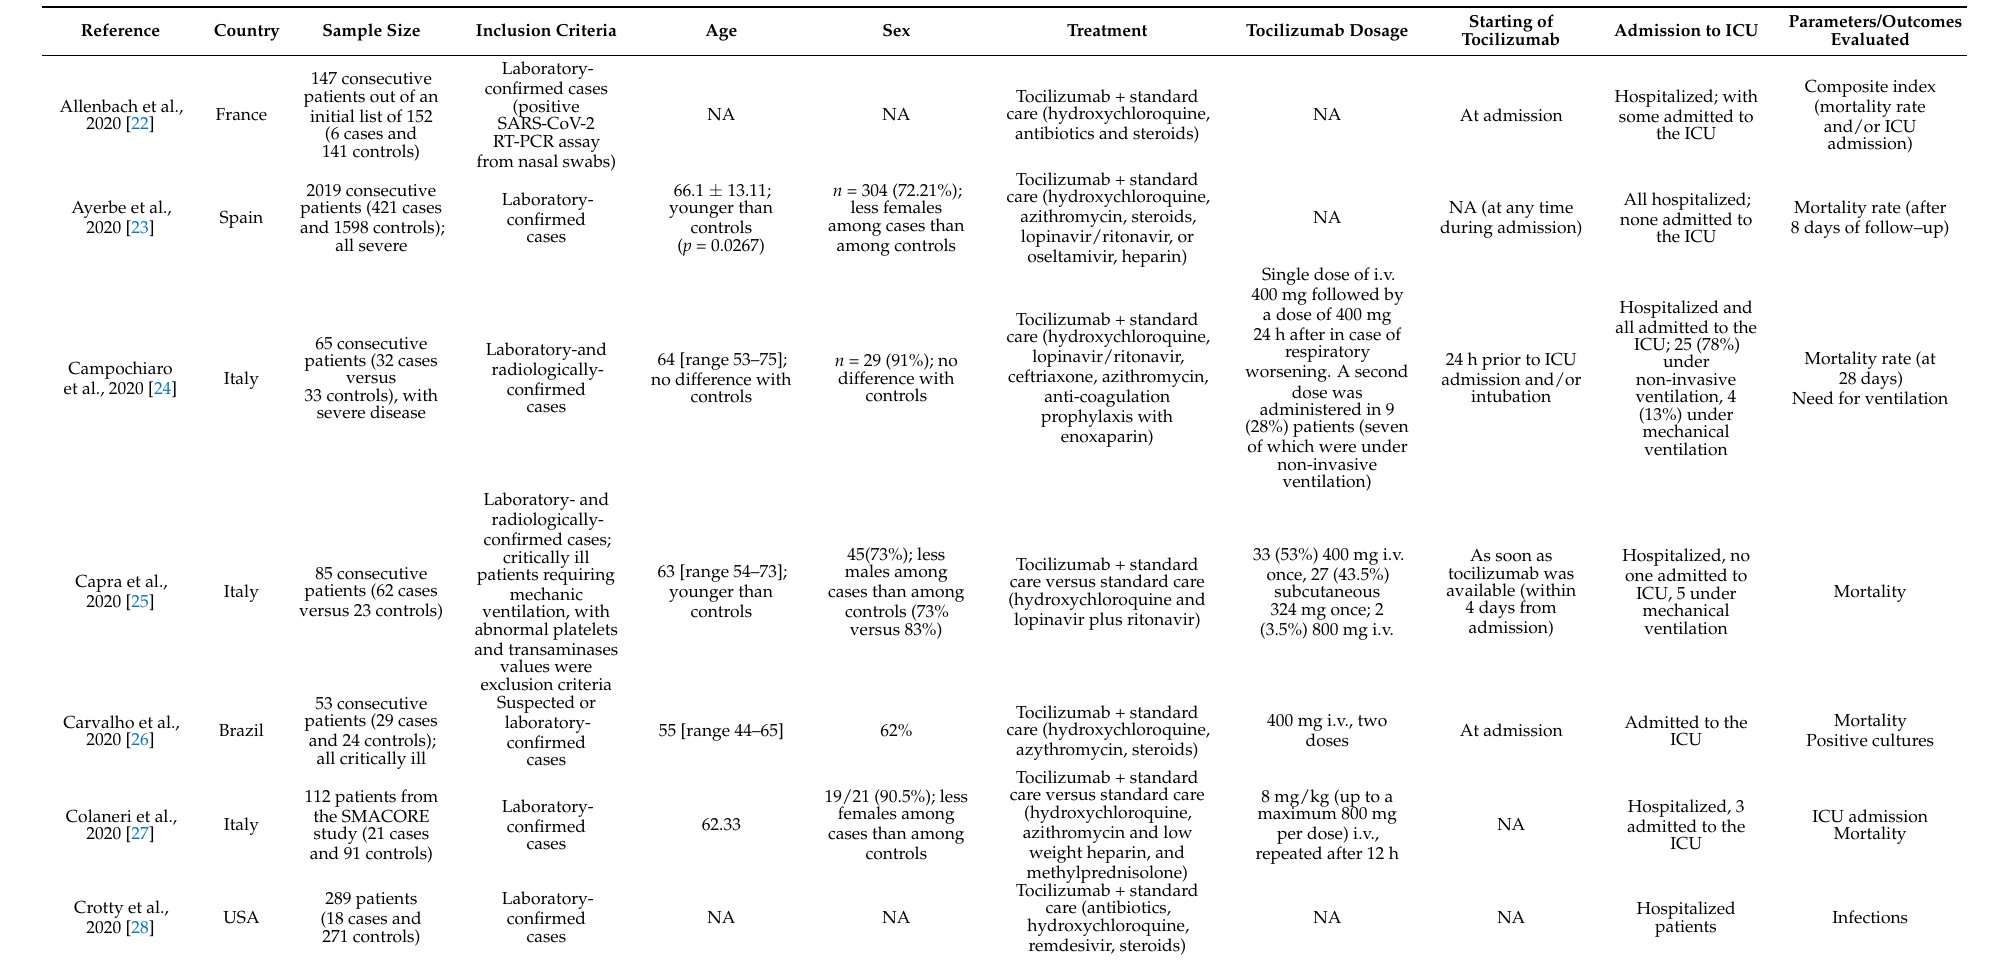
Table 2. Main characteristics of included